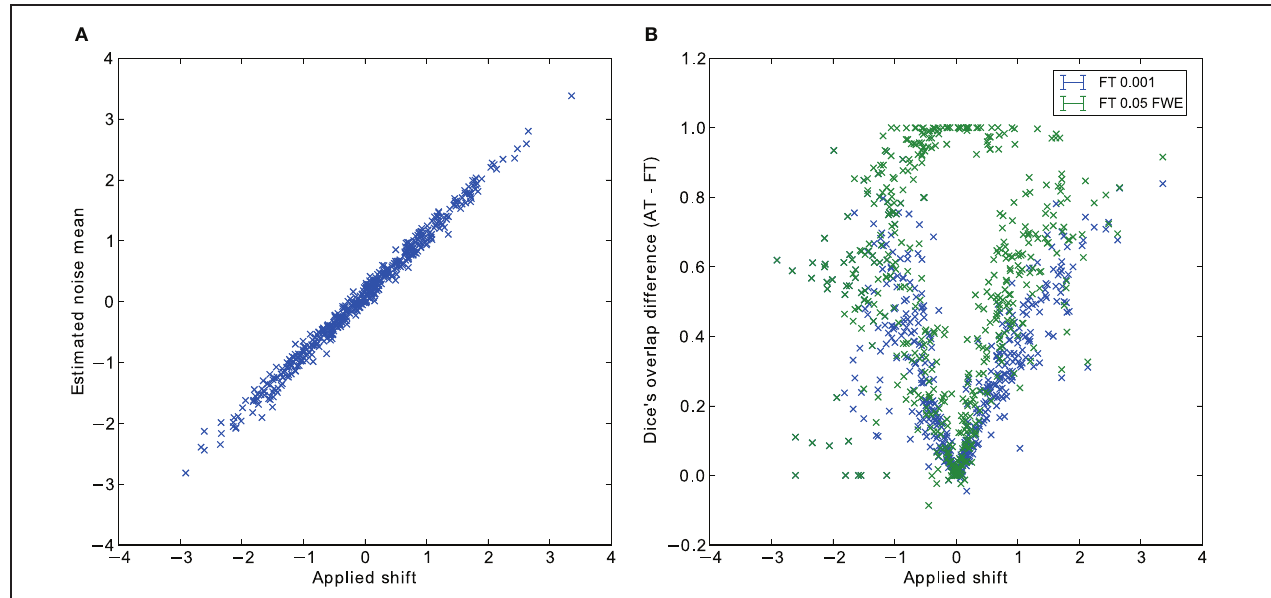
FIGURE 4 | Estimated mean of the noise component versus the applied distribution shift (A) and the improvement of AT over FT with respect to the applied distribution shift